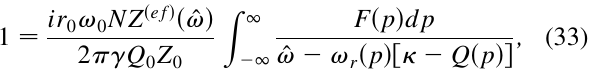
FIG. 5. Plot to calculate threshold of instability at Gaussian and function f is represented by solid line in Fig. 5. A simple fit